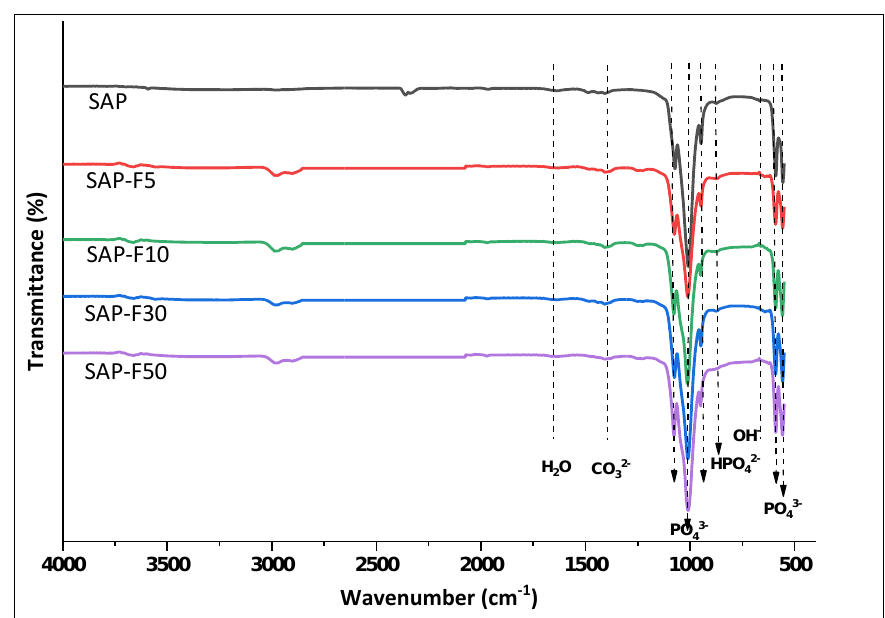
Figure 3. FT-IR analysis results of synthesized nanoparticles.